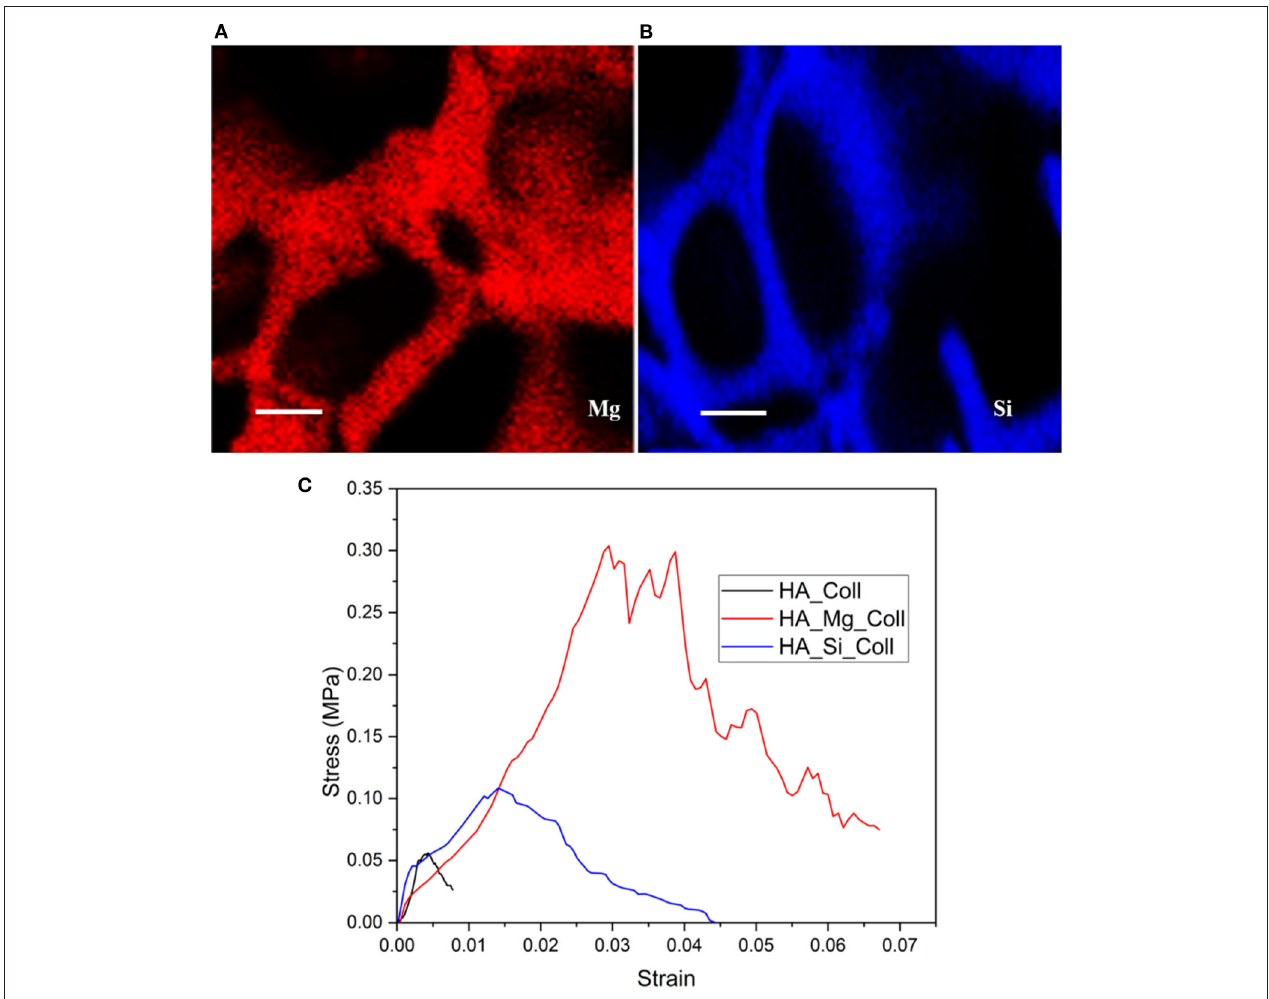
FIGURE 3 | The distribution of Mg (blue signal) and Si (red signal) elements on the surface of (A) HA-Mg and (B) HA-Si ceramic scaffolds (scale bar: 100 µ m) and representative stress-strain plot of composite scaffolds (C)